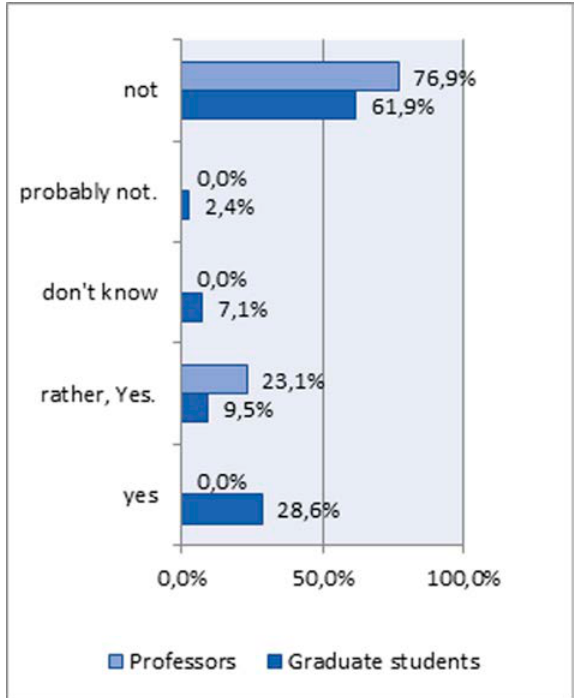
Fig. 1. Respondent Satisfaction with Higher Education Reforms.